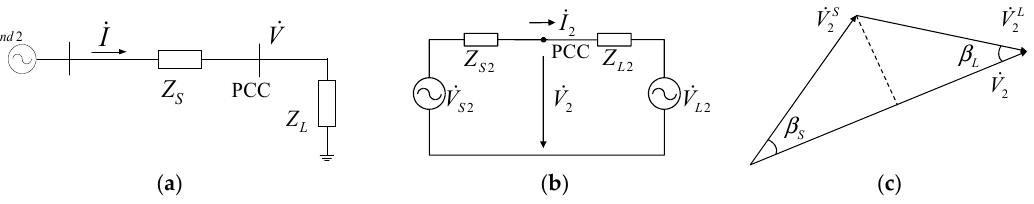
Figure 1. Analysis Circuit for the single-point unbalanced source problem: ( a ) simplified schematic circuit; ( b ) Thevenin equivalent analysis circuit; and ( c ) vector projection diagram for the contribution determination. PCC: point of common coupling.